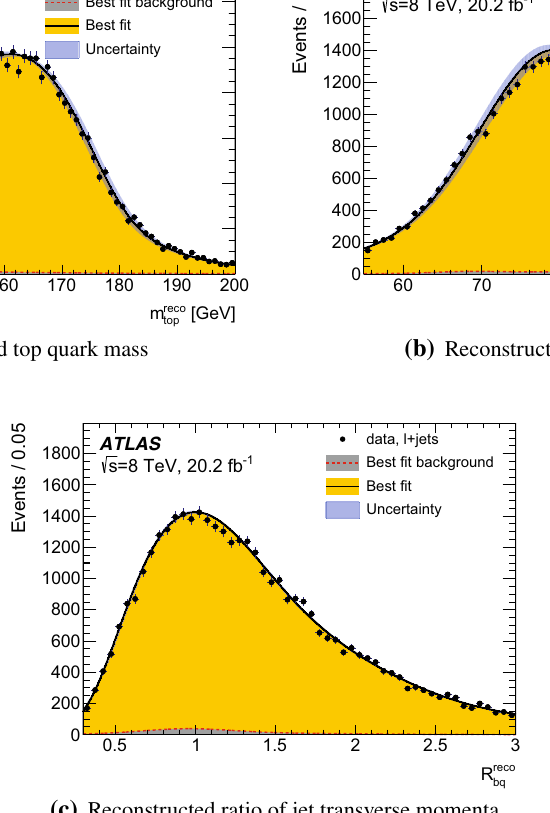
Fig. 6 Results of the likelihood fit to the data. The figures show the data distributions of the three observables with statistical uncertainties together with the fitted probability density function for the background alone (barely visible at the bottom of the figure) and for the sum of signal and background. The uncertainty band corresponds to the one and by evaluating the compatibility of selected